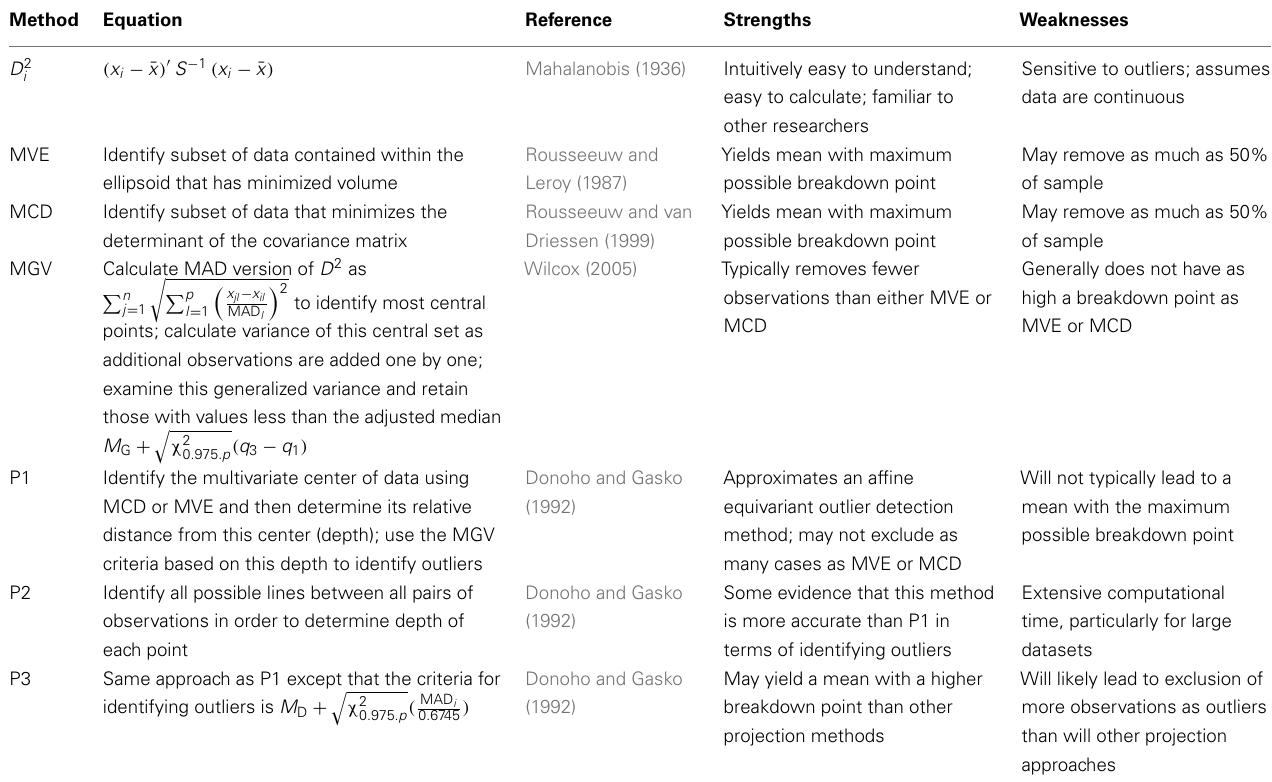
Table 1 | Summary of outlier detection